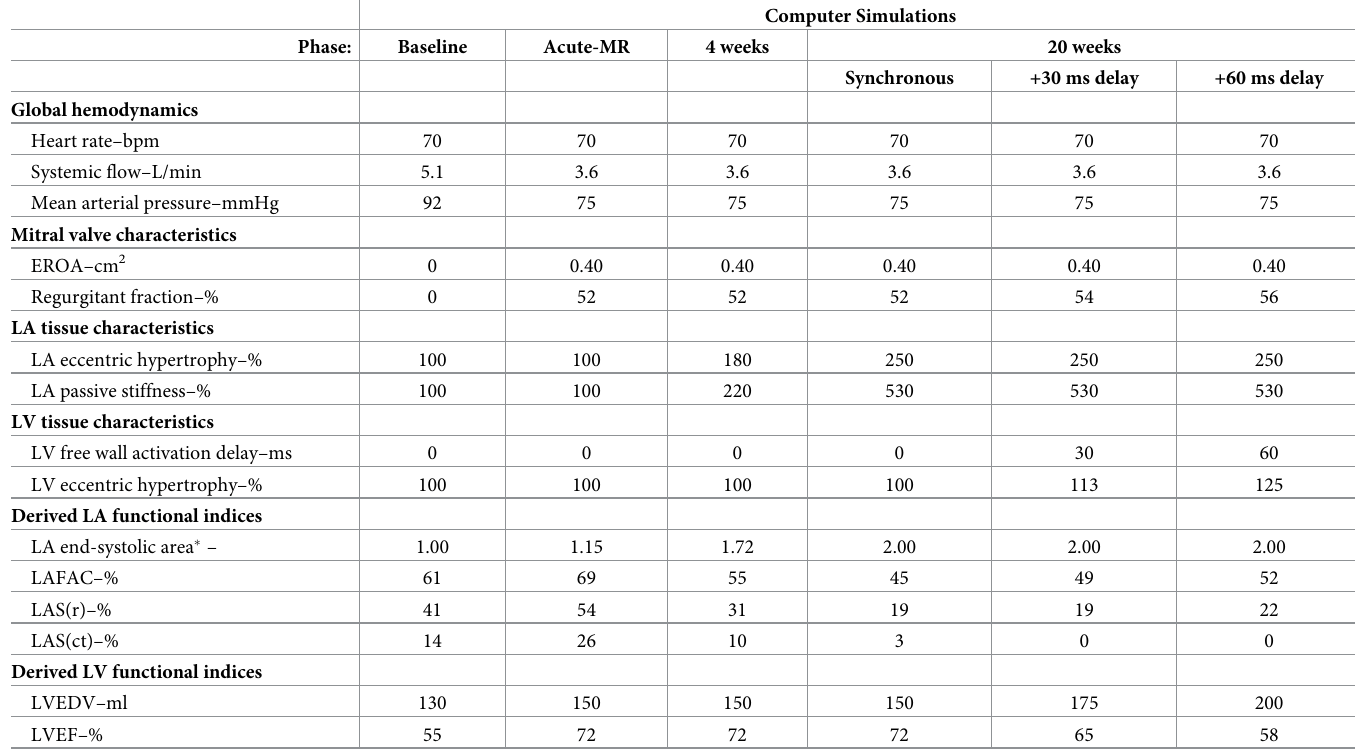
Table 2. Computer simulation characteristics and derived functional